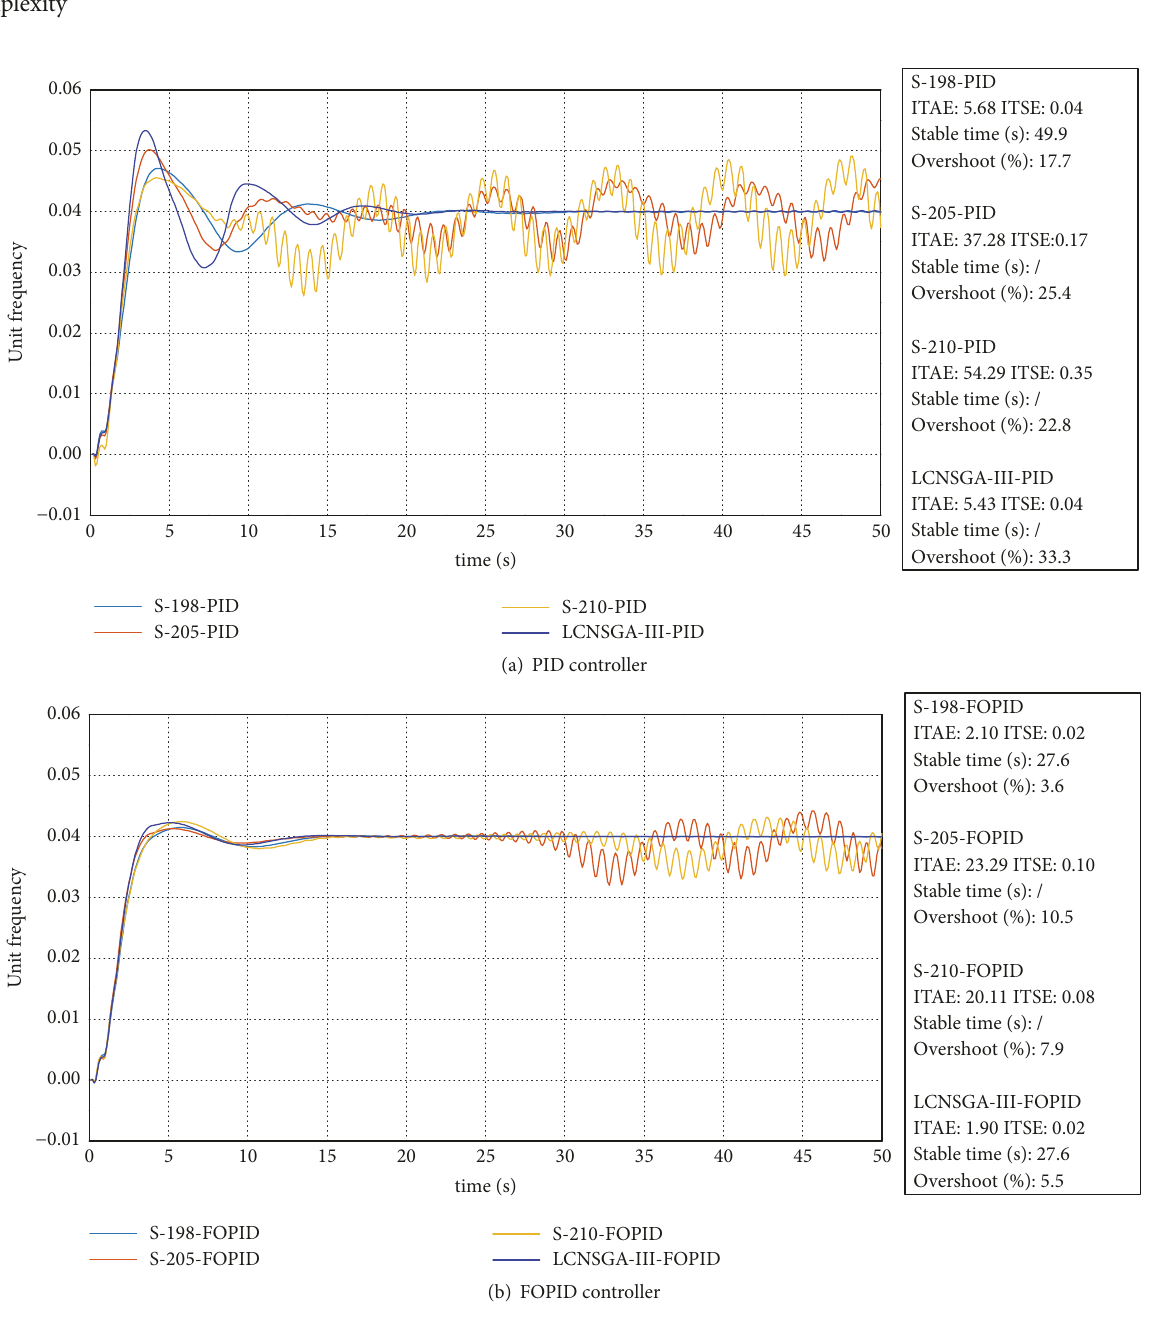
Figure 7: Unit frequency obtained at 198m working water